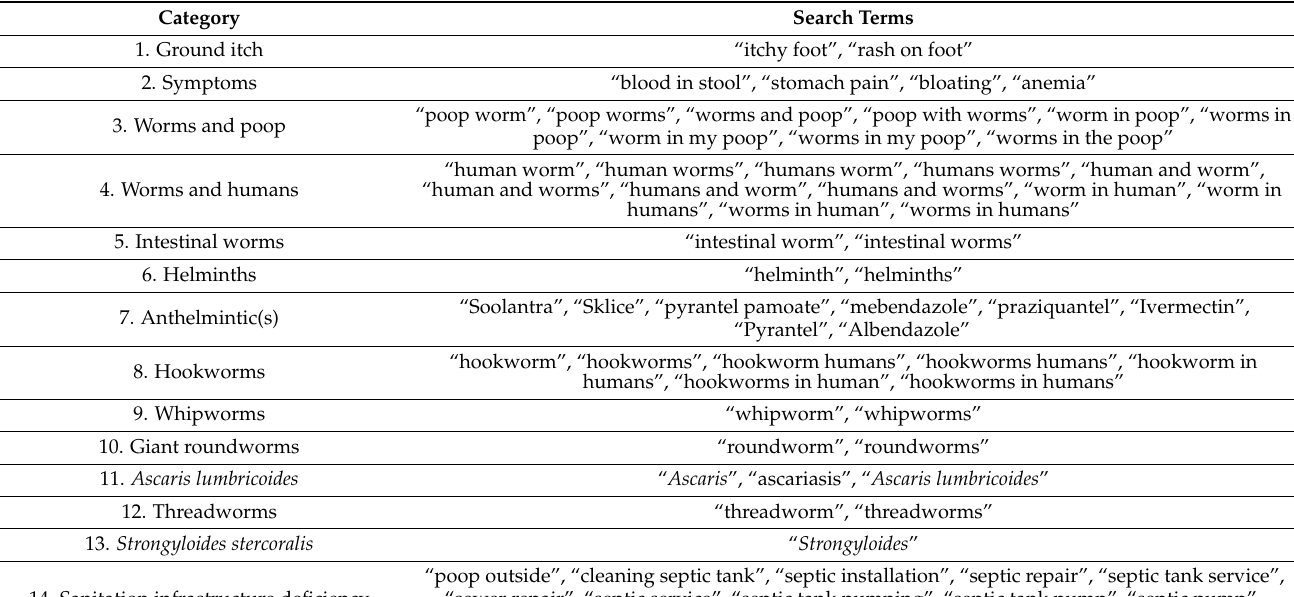
Table 1. Categorization of search terms for temporal analyses.